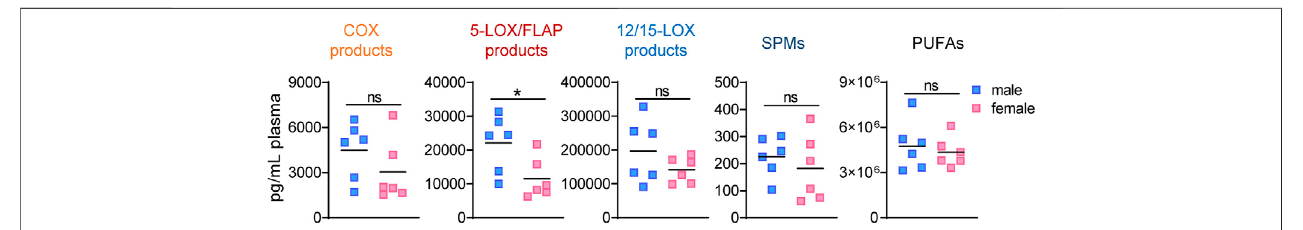
FIGURE 3 | Lipid mediator levels in plasma of male and female mice during peritonitis. Amounts of COX products (sum of PGE 2 , PGD 2 , PGF 2 α , and TXB 2 ), 5-LOX products (sum of LTB 4 , t-LTB 4 , 5-HETE, and 5-HEPE), 12/15-LOX products (sum of 12-HETE, 12-HEPE, 14-HDHA, 15-HETE, 15-HEPE, and 17-HDHA), and PUFA (sum of AA, EPA, and DHA) in plasma of male and female mice 4 h after zymosan injection. Results are shown in pg/mL plasma in scatter dot plots as individual data points and the means as black lines; n (cid:1) 5 – 6; * p < 0.05, male vs. female; unpaired Student ’ s t test; ns (cid:1) not signi fi